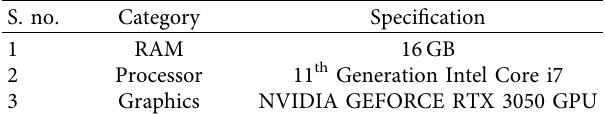
Table 2: Specifications used for the predictions. S. no.